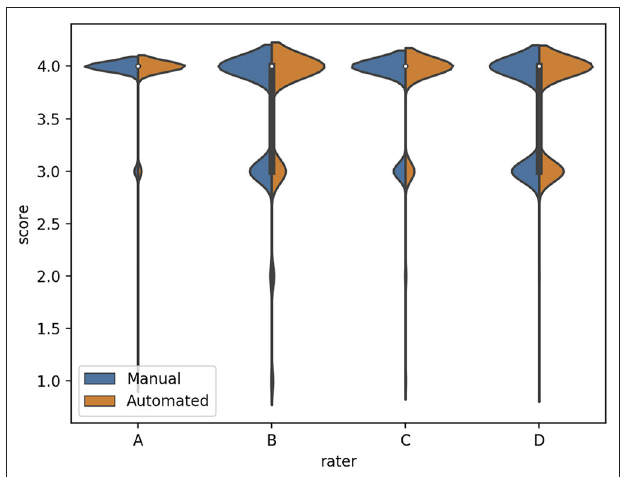
FIGURE 3 | The distribution of quality scores for each rater for both sources of contours: manual (blue) and automated (orange) segmentation.